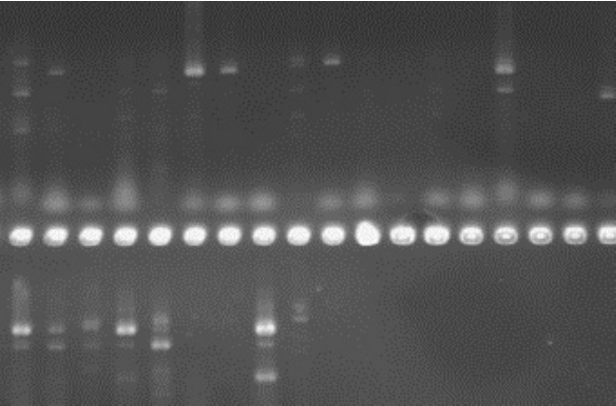
Fig. 1 - Electrophoretic profile of genes in multiplex PCR found in the samples in 1.5% agarose gel.